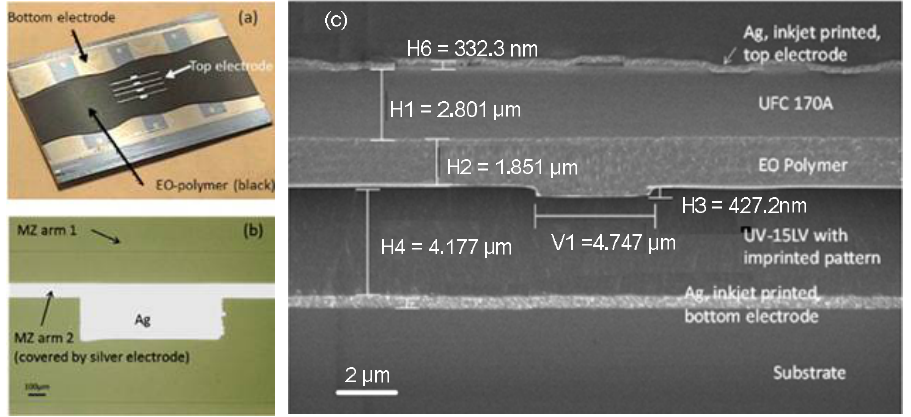
Figure 25. Microscope images of ( a ) printed EO polymer modulator; ( b ) ink-jet printed top electrode; and ( c ) SEM picture of the modulator cross section [80]. Copyright 2013 OSA.